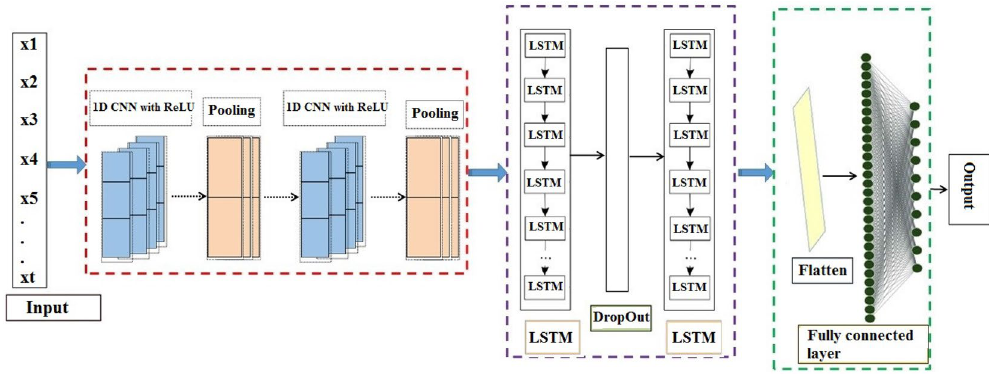
Figure 4. Conceptual diagram of the 1DCNN-LSTM